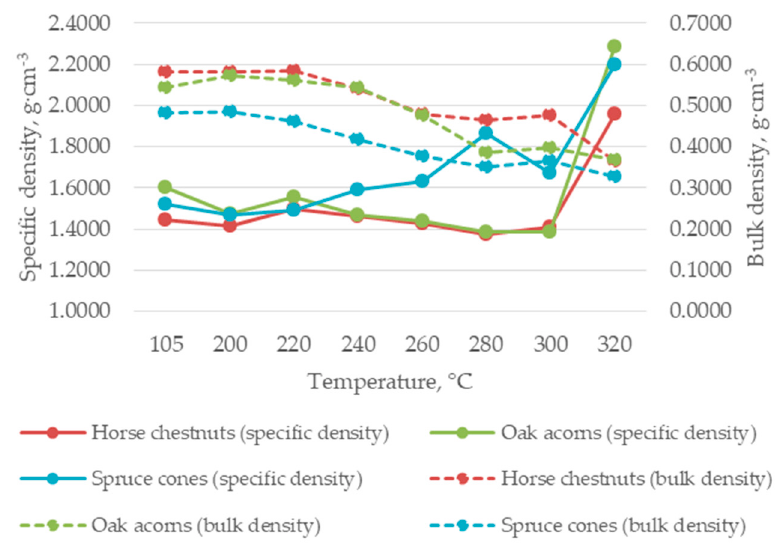
Figure 12. Specific and bulk density of the raw and torrefied forestry biomass.